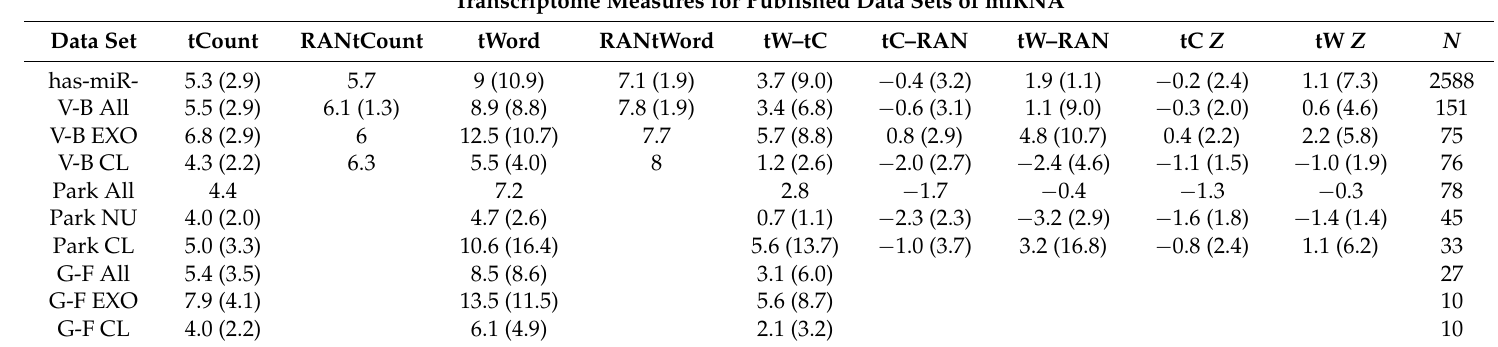
Table 2. Various measures of word similarity to simple model transcriptome from 4 data sources. Transcriptome Measures for Published Data Sets of